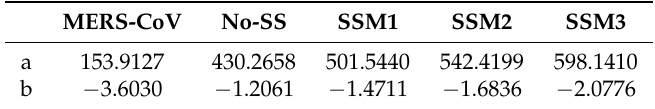
Table 3. Parameter estimation for the distributions of secondary